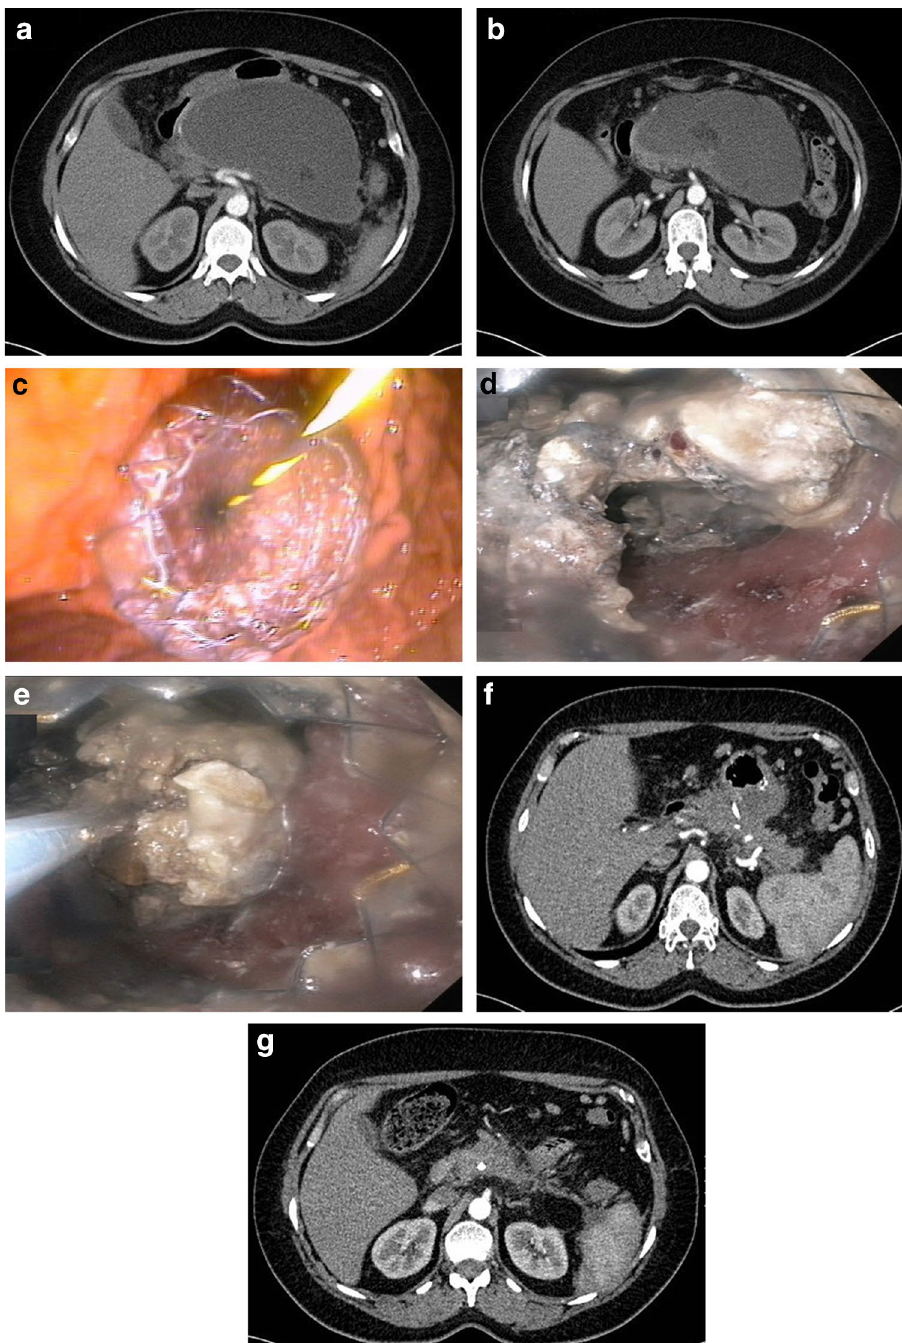
Figure 2. a – g Endoscopic treatment of walled-off pancreatic necrosis. A 62-year-old female patient qualified for drainage of infected walled-off pancreatic necrosis on day 48 of acute necrotizing pancreatitis ( a , b ). Transmural endoscopic drainage ( c ) and numerous direct endoscopic necrosectomy procedures were performed ( d , e ). On control contrast-enhanced abdominal and pelvic computed tomography ( f , g ) after 12 months since the endoscopic treatment, a complete regression of necrotic collections was